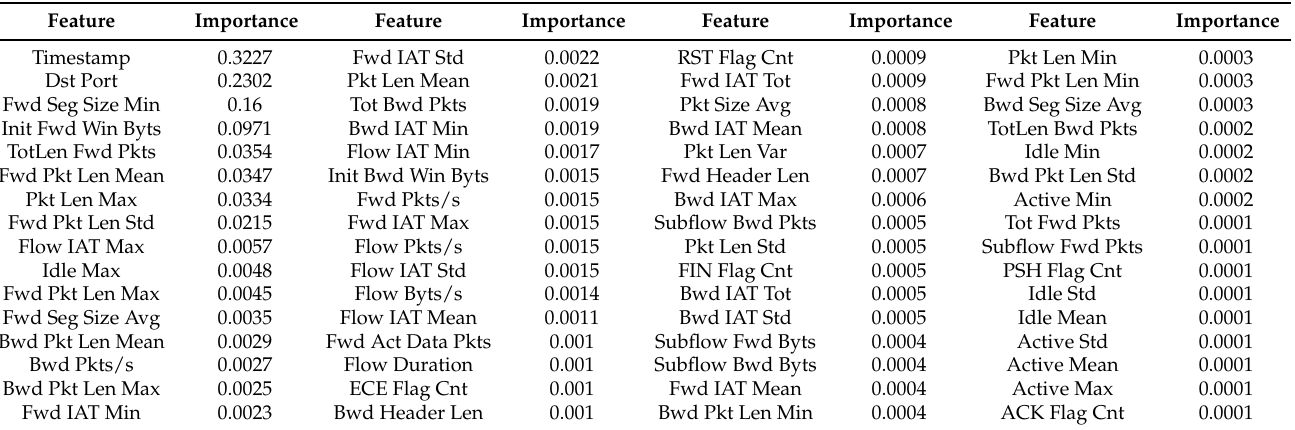
Table 4. Selected feature for the training of each of the models using random forest feature importance according to the standard deviation of feature values.